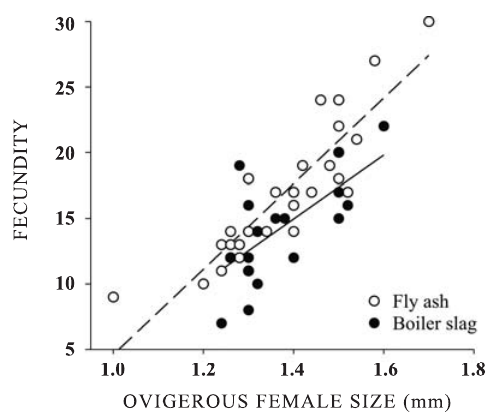
Figure 2. Relationship between Benthana taeniata fecundity (marsupial content) and body size (cephalothorax width), in females from two coal residue deposits (fly ash and boiler slag). Each point represents one vigerous female (n = 53; R 2 =